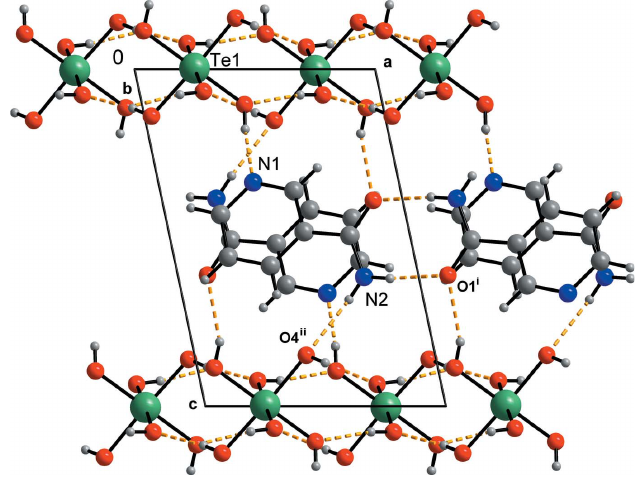
Figure 4 View ( DIAMOND ; Brandenburg & Putz, 2005) of the title structure along the b axis. C, H, N, O and Te atoms are represented by grey, small grey, blue, red and green circles, respectively. Hydrogen bonds are shown as yellow dashed lines. Symmetry codes as in Table 2